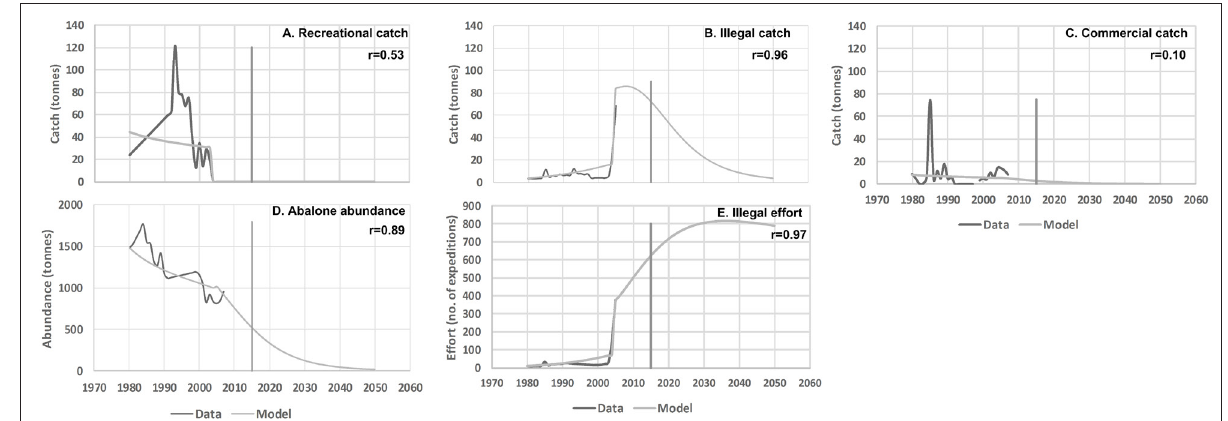
Figure 3: Baseline simulations showing how the model outputs of catch, abundance and effort replicate the historical data. The vertical line in each graph indicates the 2015